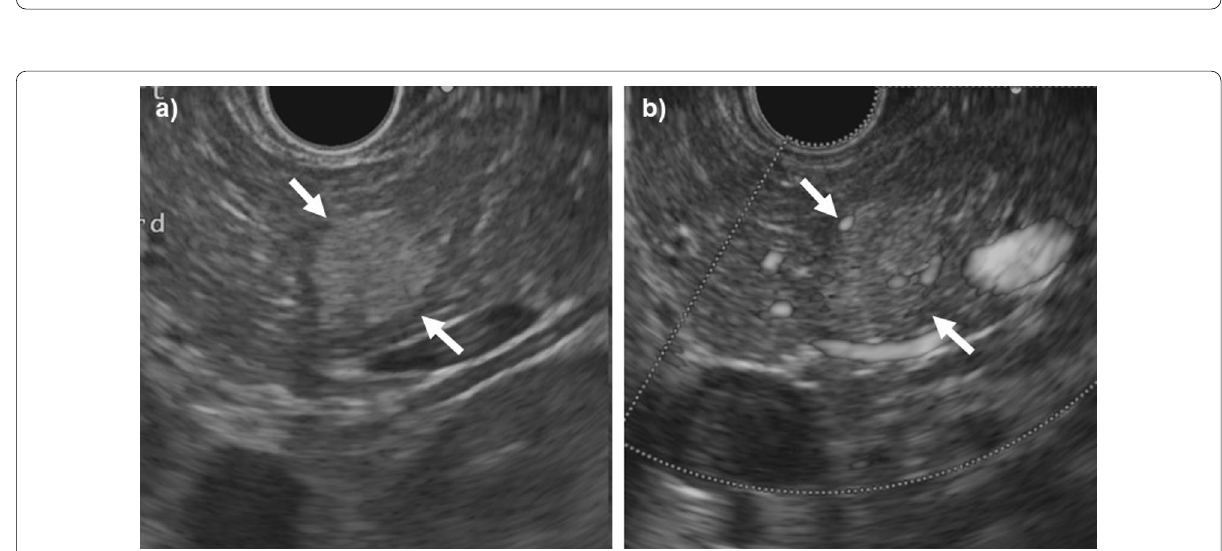
Fig. 3 EUS. a B mode and b color Doppler. EUS revealed a hyperechoic mass with distinct borders and homogeneous interior in the tail of the pancreas (white arrows in a ). Color flow Doppler imaging showed abundant internal blood flow inside the tumor (white arrows in b